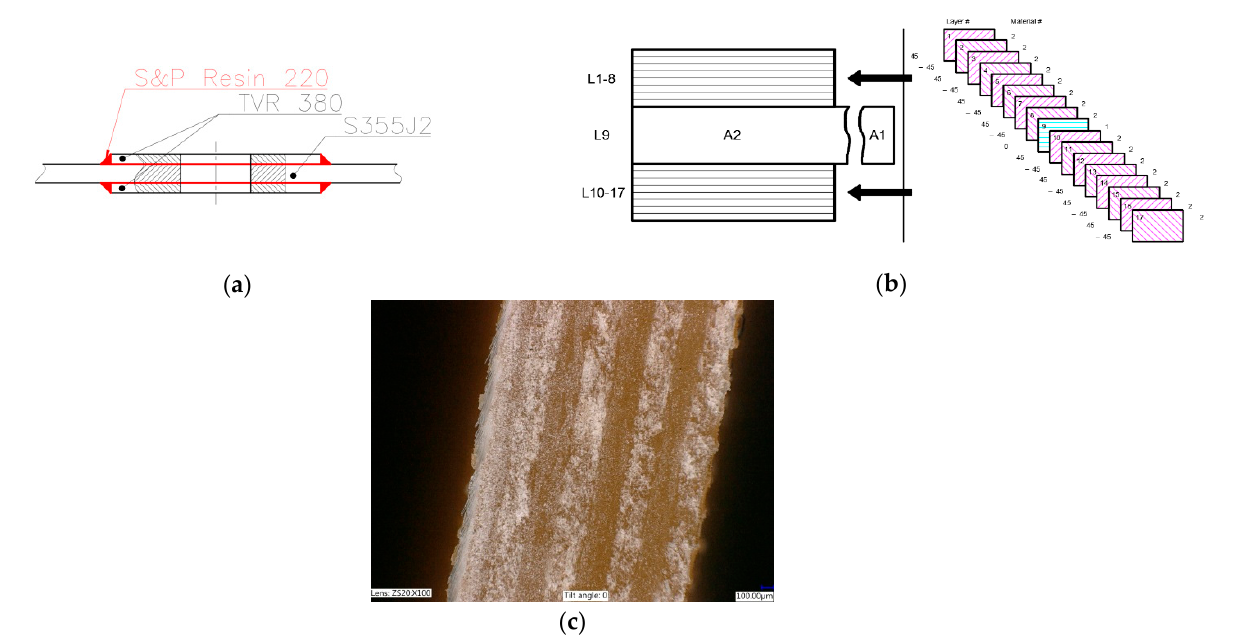
Figure 3. Design of sample 5 with composite overlays: ( a ) structure of adhesive joint; ( b ) stacking sequence and numbering of layers; ( c ) microscopic image of the composite [+45°/ − 45°] 4 material.